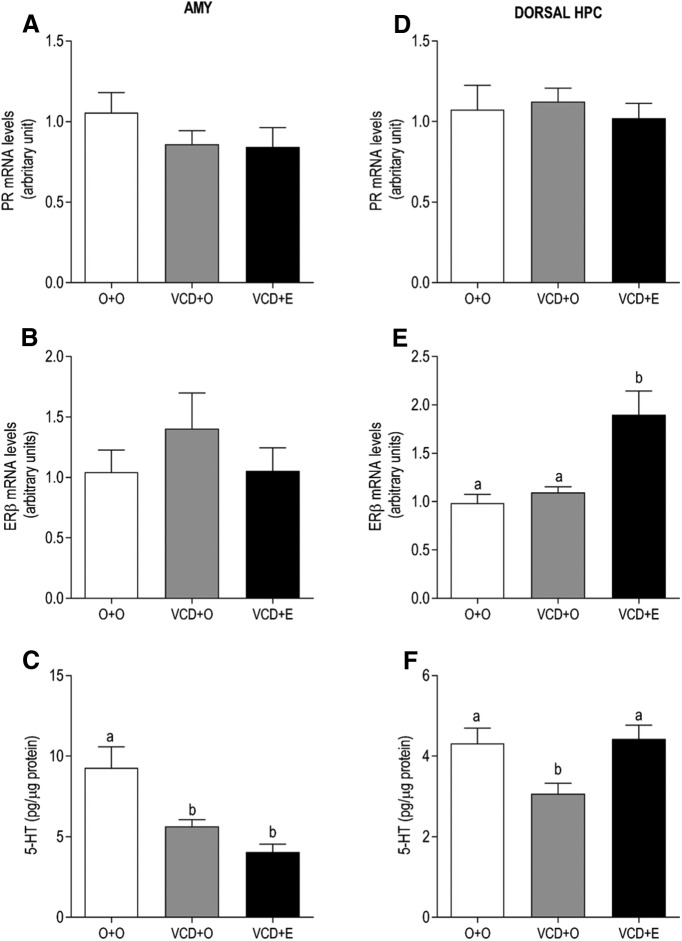
Effects of follicular depletion induced by VCD and chronic 17β-estradiol (E) administration on PR and ERβ mRNA levels and 5-HT content in the AMY (A–C) and dorsal HPC (D–F). Female rats at 28 d of age were subcutaneously injected with corn oil (O) or VCD for 15 consecutive days. Fifty-five days after the first injection of VCD/oil, rats received a subcutaneous capsule that contained corn oil (groups O + O and VCD + O) or 17β-estradiol (VCD + E). Rats were decapitated during the diestrous phase (O + O and VCD + O groups) or 21 d after the onset of E therapy (VCD + E), from 75 to 85 d after the onset of VCD/oil administration, between 9:00 and 11:00 A.M. Data are presented as the mean ± SEM. Significance was accepted at p < 0.05. Different letters indicate significant differences (n = 6-9).